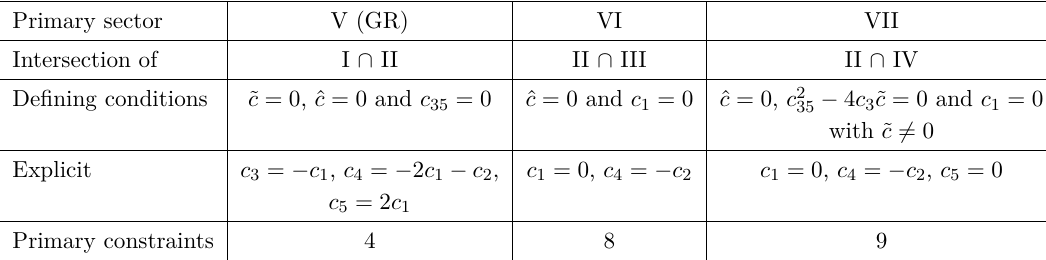
Table 2 . Defining conditions and properties of the primary sectors V–VII.